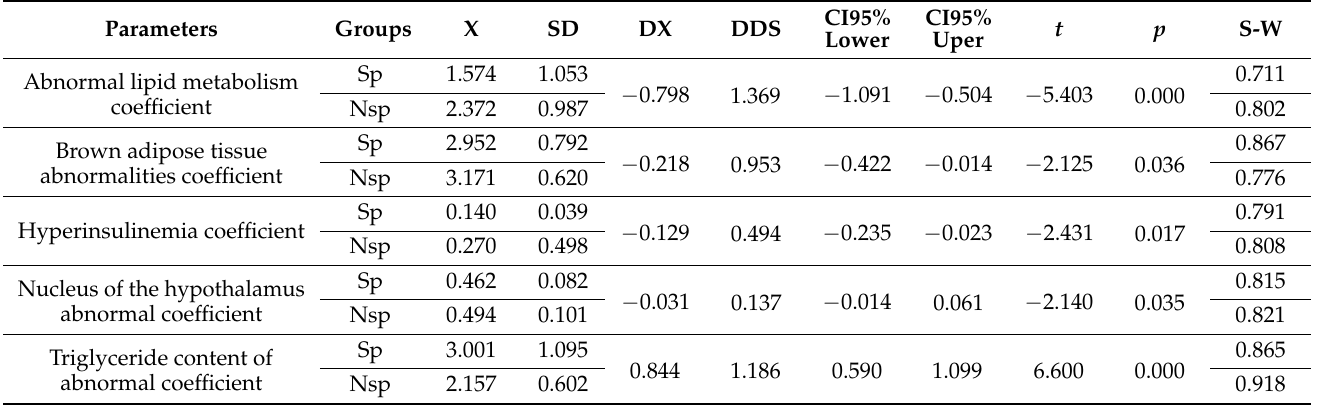
Table 2. Statistical analysis of the obesity analysis report for the male